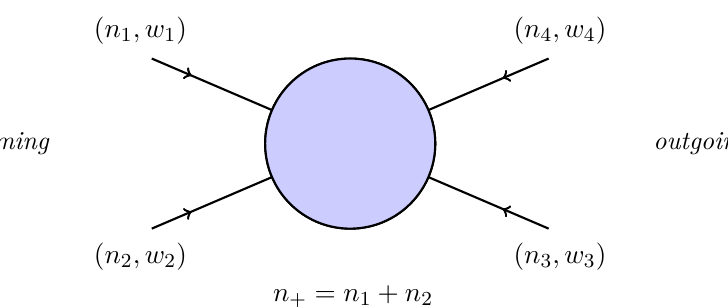
Figure 1 . Closed string amplitude with momentum and winding data ( n i , w i ) obeying conservation laws n 1 + n 2 + n 3 + n 4 = 0 and w 1 + w 2 + w 3 + w 4 = 0 . Here, n 1 , n 2 > 0 and n 3 , n 4 ≤ 0 ,